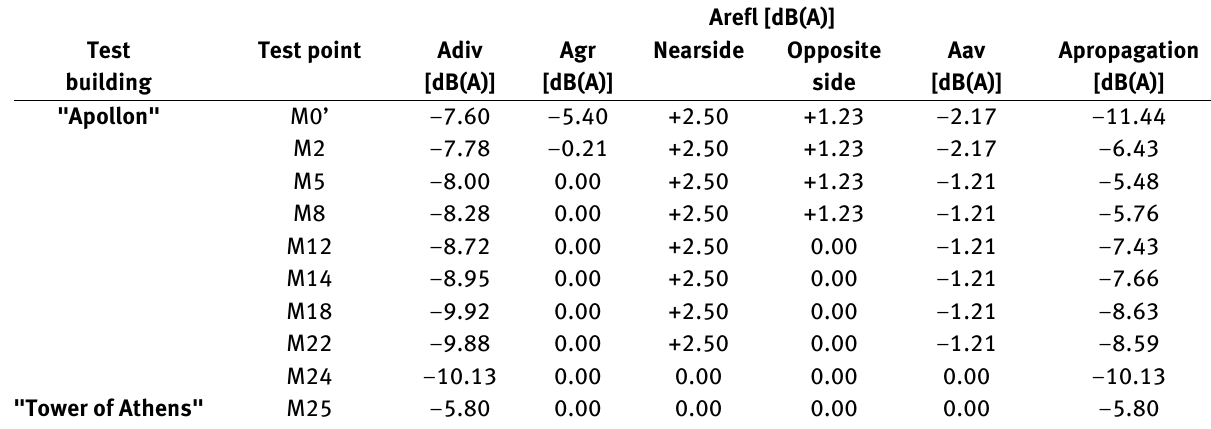
Table 3: Corrections, applied to the measured sound level at reference point M0 (Table 2) . Adiv: correction due to geometrical divergence, Agr: correction due to ground cover effect, Arefl: correction due to façade reflections, Aav: correction due to angle of view effect, Apropaga- tion: total